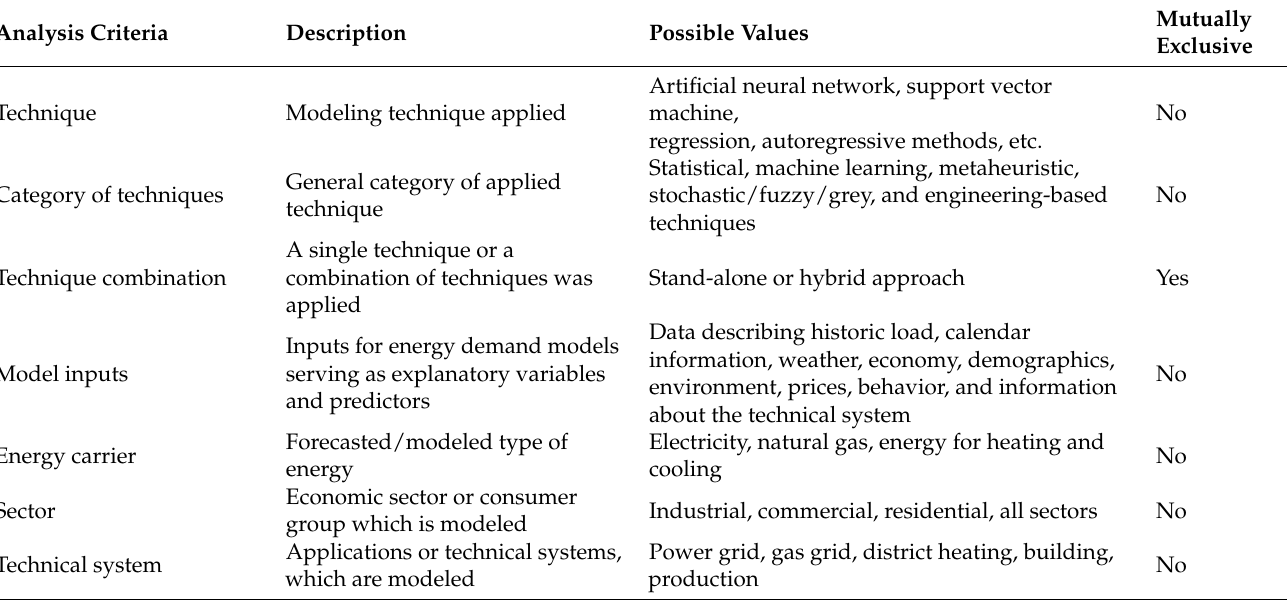
Table 2. Assessment criteria. Overview of analysis criteria defining the collected data during step three of the review procedure. Each item represents a property characterizing the techniques applied in the respective articles. A short description and possible values are given. For mutually exclusive criteria only one value is possible, while for non-exclusive properties multiple values can be given and counted multiple